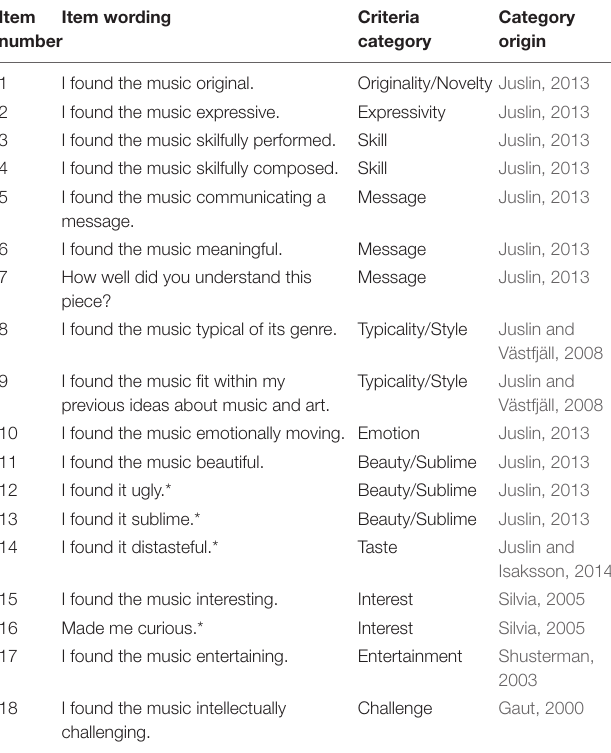
TABLE 2 | Aesthetic judgment criteria items and categories used in